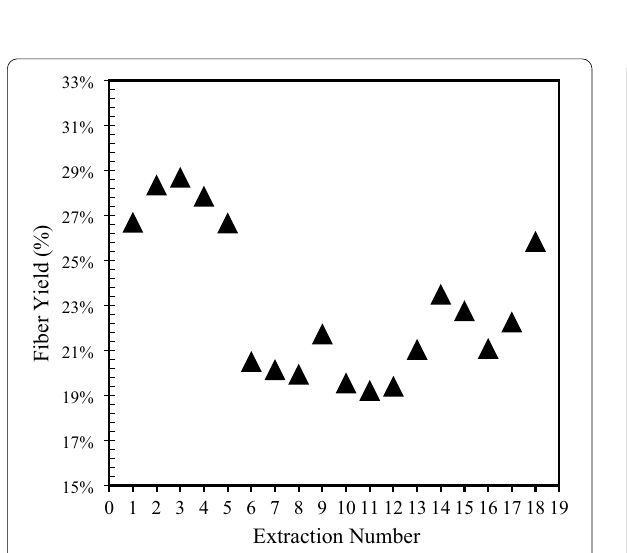
Fig. 5 Distribution in diameter of cattail